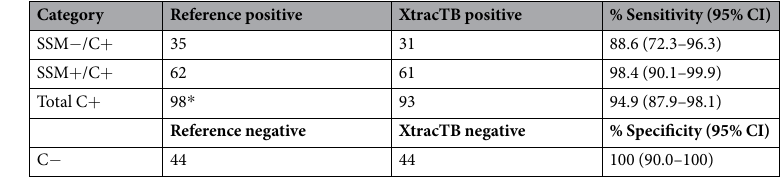
Table 3. Summary of testing results of XtracTB Assay with improved process of FIND TB specimen panel (Included specimens = 142). SSM − = concentrated sputum smear microscopy negative; SSM + =